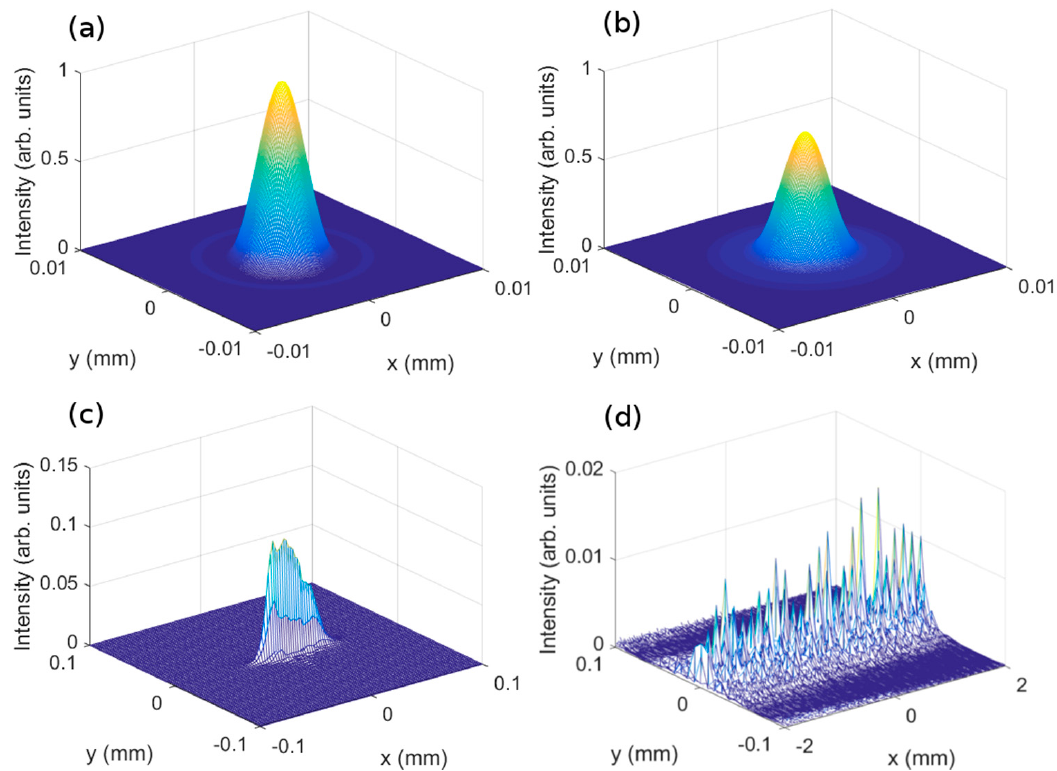
Figure 6. Intensity distribution at the image plane of asymmetrical, ( a ) and ( b ), and symmetrical, ( c ) and ( d ), HLs recorded ( a ) and ( c ) at 473 nm and ( b ) and ( d ) at 633 nm wavelength.